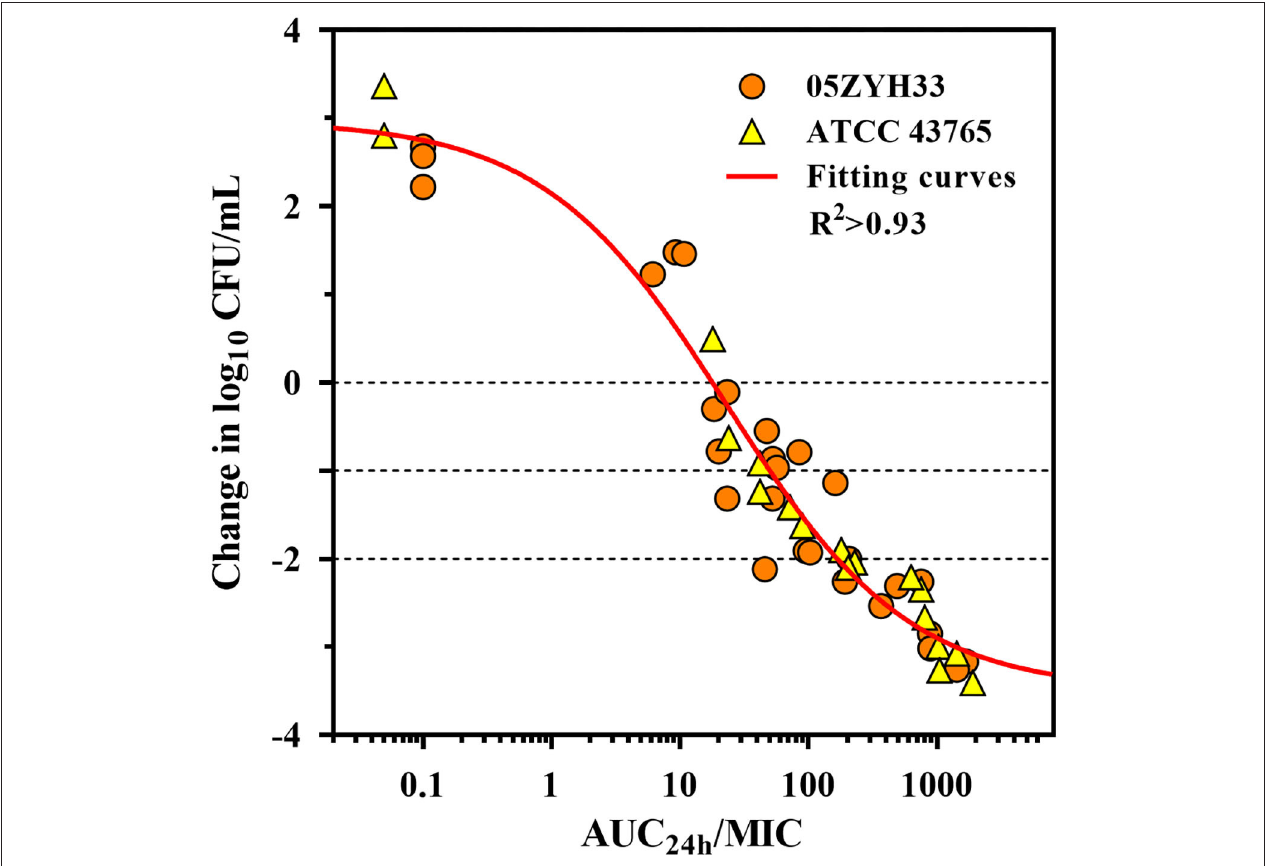
FIGURE 5 | Gamithromycin pharmacokinetic/pharmacodynamic (PK/PD) relationship for S. suis . Correlation plots between ex vivo activity and area under the concentration (AUC 24h )/MIC ratio of gamithromycin against S. suis 05ZYH33 and ATCC 43765 using the sigmoid E max model. The fitting curve represents the predicted values, and the points represent the observed values of individual serum samples collected from 0 to